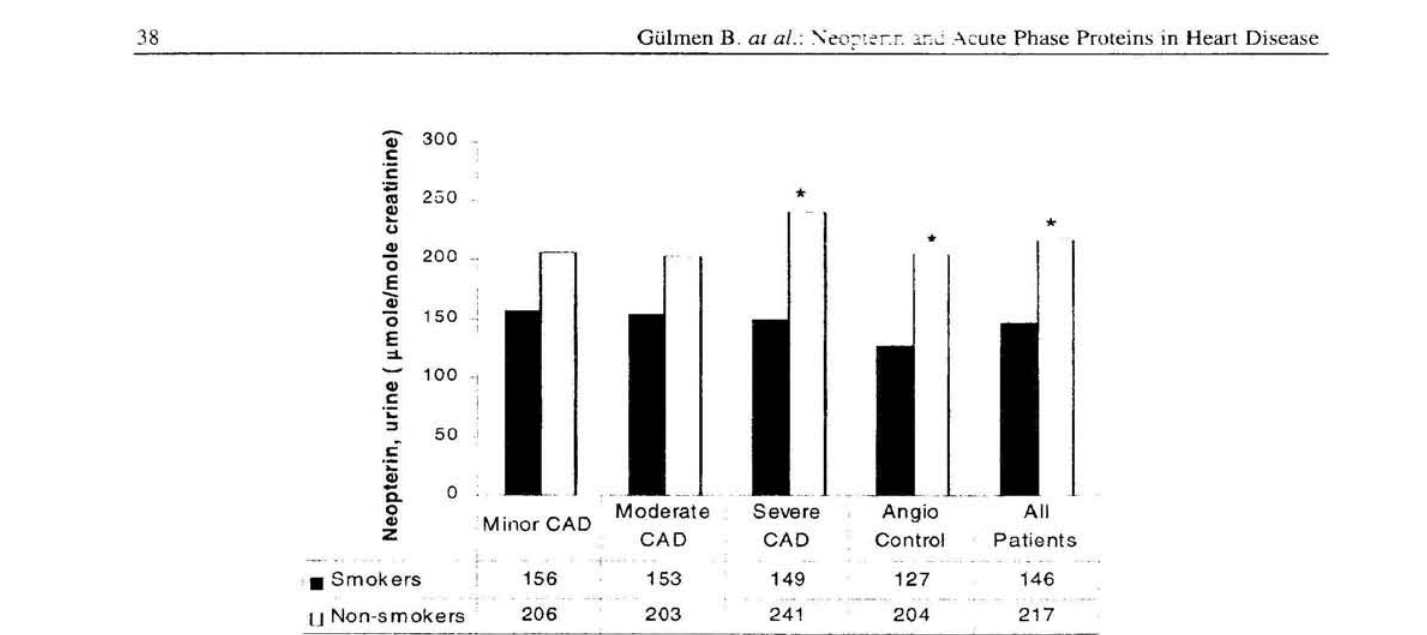
Figure 1. Urine neopterin concentraüons of patients with coronary artery disease (CAD), groups stratified l'or Smoking status. Data are presented as means. *p <0.05, smokers vs non-smokers within groups 2.61 nmole/I, p <0.05). Comparison of healthy controls wiih patients angiographically free of CAD (group IV), revealed significantly higher neopterin levels in group IV (10.8 ± 6.6 vs 7.5 ± 2.6 nmole/1, p <0.05). Serum neopterin levels did not differ between the four angiography.